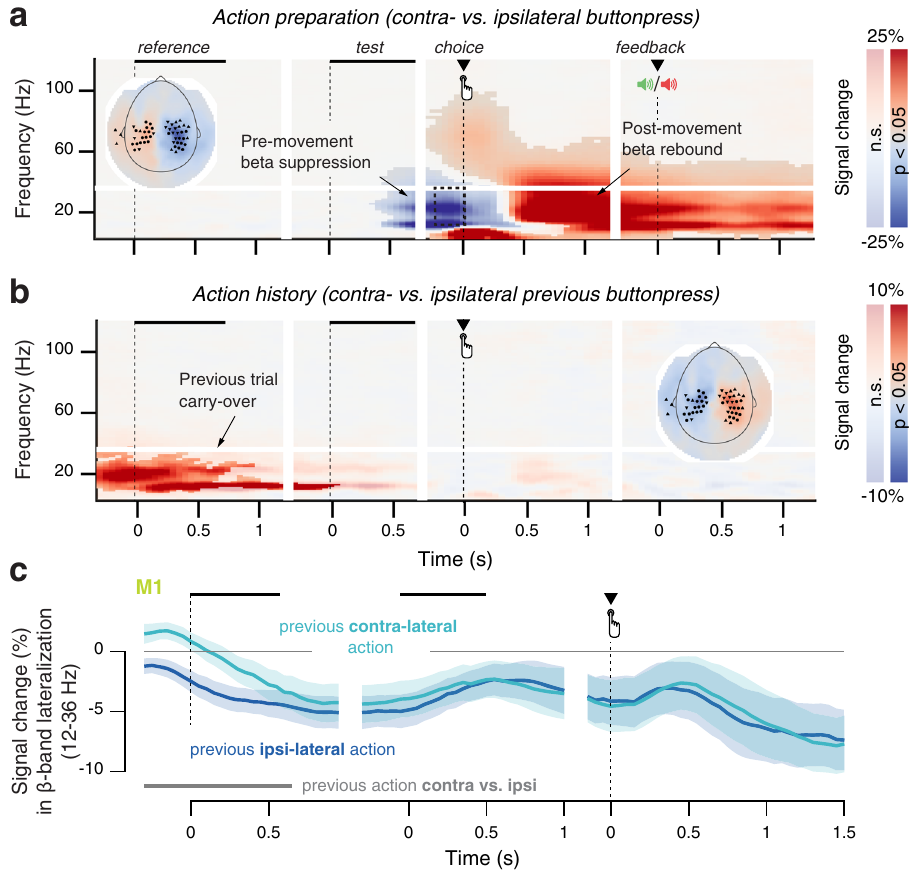
Fig. 3 | Action-related MEG dynamics in motor cortex. a Time – frequency representation of action-related MEG power lateralization (contralateral vs. ipsi- lateralto buttonpress) over motorcortex.Inset: motorsensors, selectedbasedon pre-movement beta-band lateralization. Shading indicates signi fi cant clusters in time-frequency space, as determined by a cluster-based permutation test on